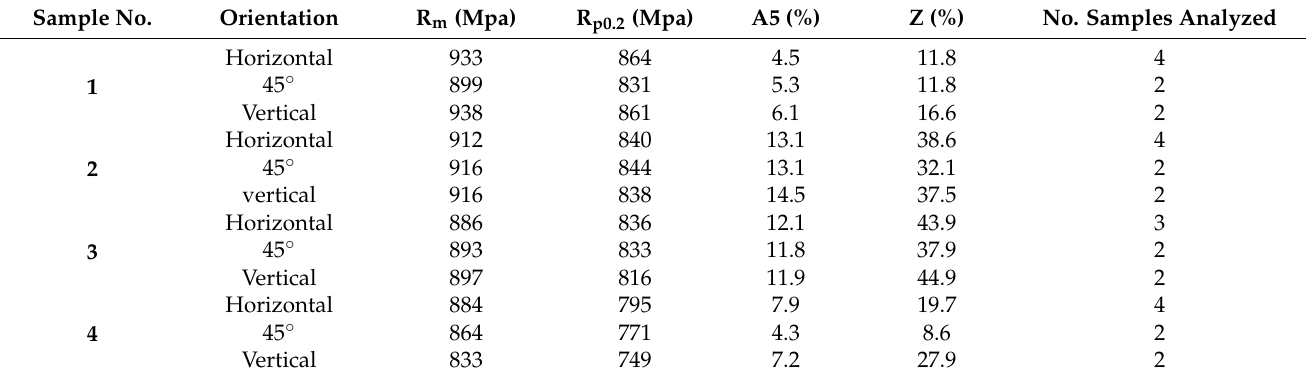
Table 4. Tensile test results. For thermomechanical treatments of samples analyzed, see Table 3. Sample